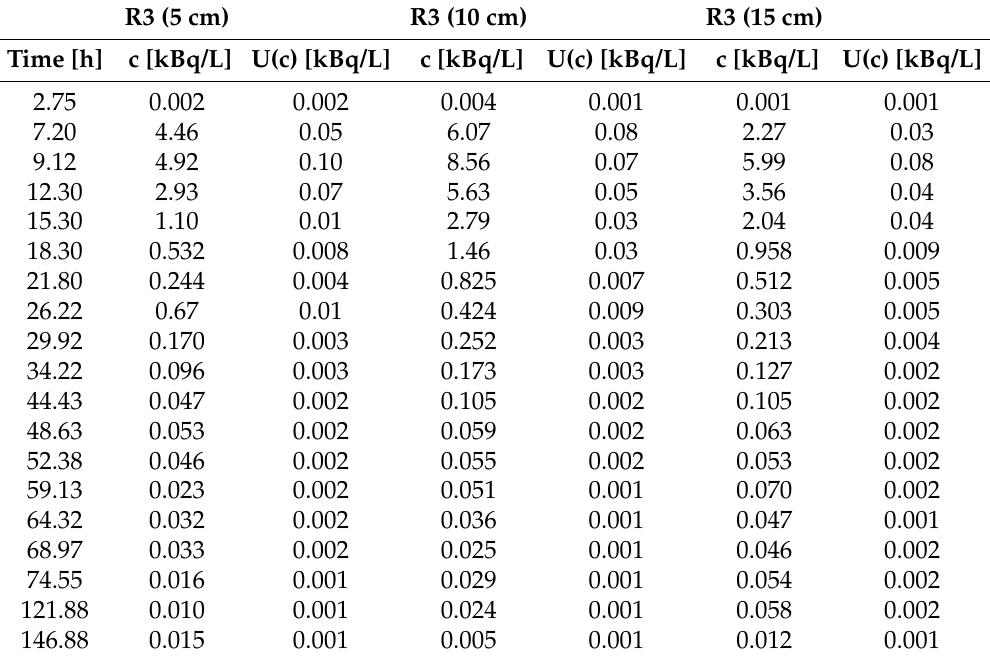
Table A3. Hyporheic 3 H activity concentrations and their analytical uncertainties at point R3.